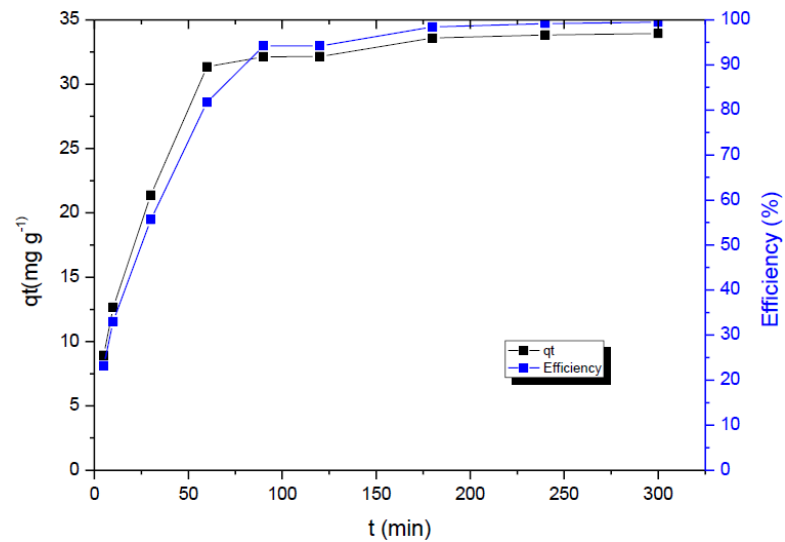
Figure 4. The effect of contact time onto adsorption efficiency (%) and capacity (mg g −1 ); experimental conditions: C i = 7.75 mg L −1 , adsorbent dose 0.23 g L −1 , pH 6.46, temperature 22 °C, stirring 170 rpm.